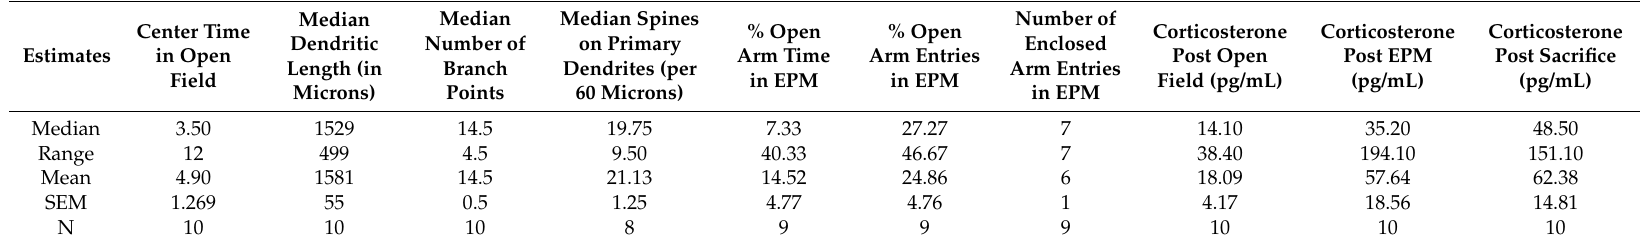
Table 1. Sample statistics for endpoints measured in this study.